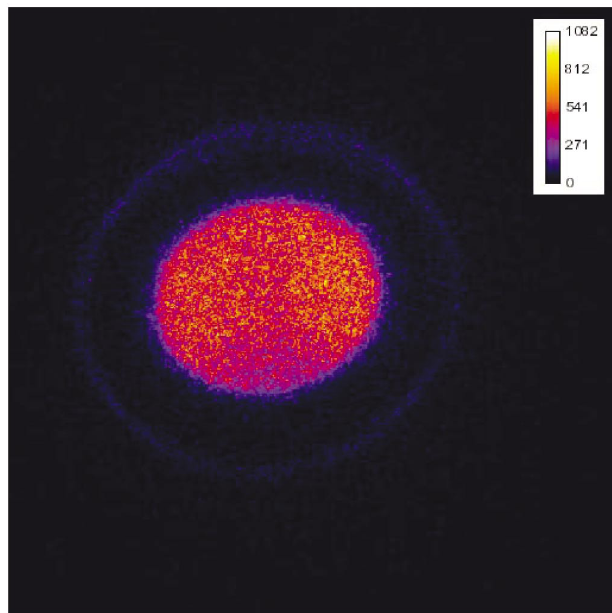
FIG. 16. (Color) Evidence of beam halo formation in configu- ration space. Image for a 6% off-energy beam, measured at end of the final-focus system (beam size (cid:3) 2 cm ).